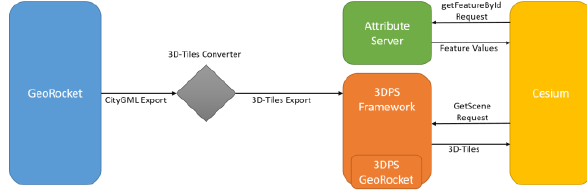
Figure 4. The data flow from GeoRocket to the visualized 3D Tiles, which are requested via the 3D Portrayal Service queries.